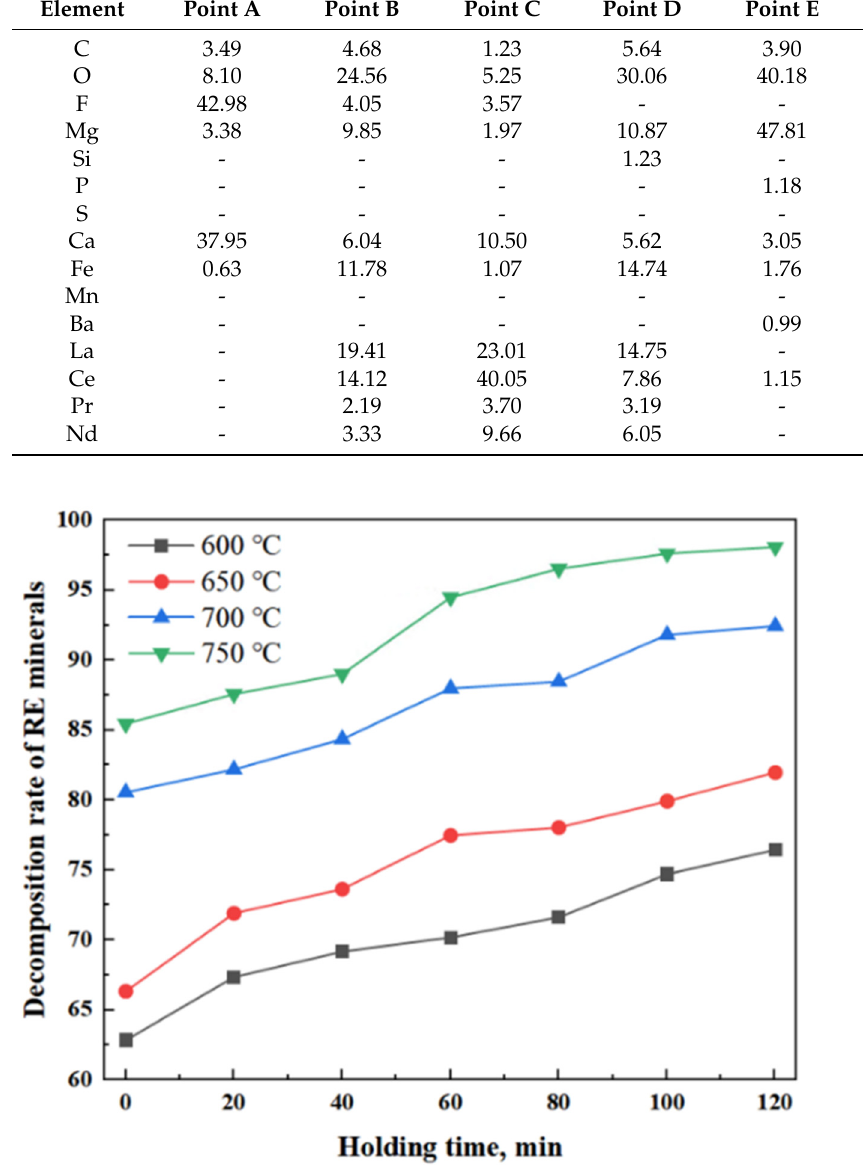
Figure 8. Effect of roasting temperature and holding time on the decomposition rate of RE minerals. With the hold time of 120 min, the maximum decomposition rates at 600 ◦ C, 650 ◦ C, 700 ◦ C, and 750 ◦ C reached 76.45%, 81.97%, 92.44%, and 98.09%, respectively. It should be noted that the decomposition rates for all the cases exceeded 60% during the temperature- rising stage. The SEM-EDS results of the leaching residues are shown in Figures 9 and 10 and Table 3. The BaSO 4 particles (marked as “H”, “L” and “N” in Figure 9) and the Na(Fe, Sc)Si 2 O 6 particles (marked as “J” and “K” in Figure 9) were detected in all leaching residues. The particles marked as “G” and “M” in Figure 9 contain Nb, Ti, Fe, Ce, Nd, and Ca, which belong to niobium minerals such as pyrochlore-group(Ce 2 Nb 2 O 6 (OH) 2 ), ilmenorutile ((Ti, Nb, Fe)O 2 ), and eschynite (CeTiNbO 6 ), according to the study of Zhang et al. [19]. These undecomposed niobium minerals are the reasons for the decomposition rate of RE minerals not reaching 100% at 750 ◦ C. While the reason for the low decomposition rate before 750 ◦ C is the undecomposed REPO 4 , which was observed in the sample roasted at 600 ◦ C, as shown by the particles marked “I” in Figure